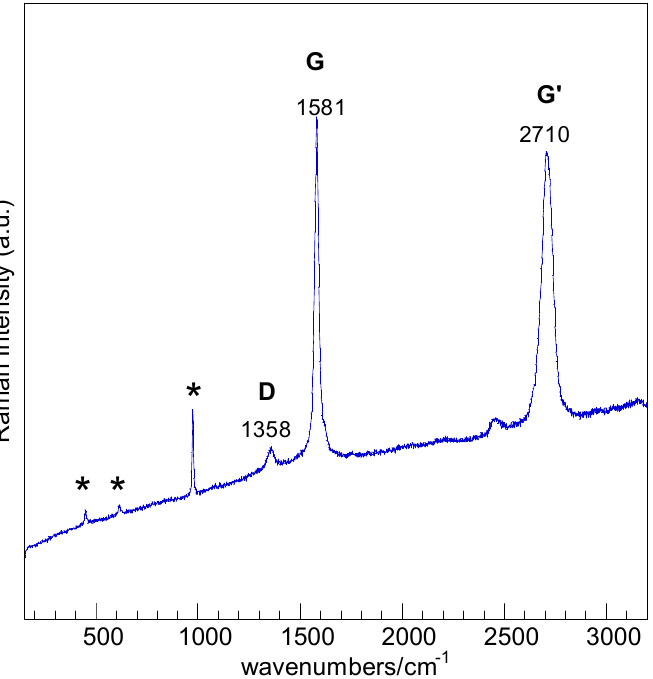
Figure 2. Typical Raman spectrum of carbon nanotubes spots. Bands marked by a star (*) are due to sulfates impurities. D, G, G’ are the typical D, G and G’ bands, respectively,